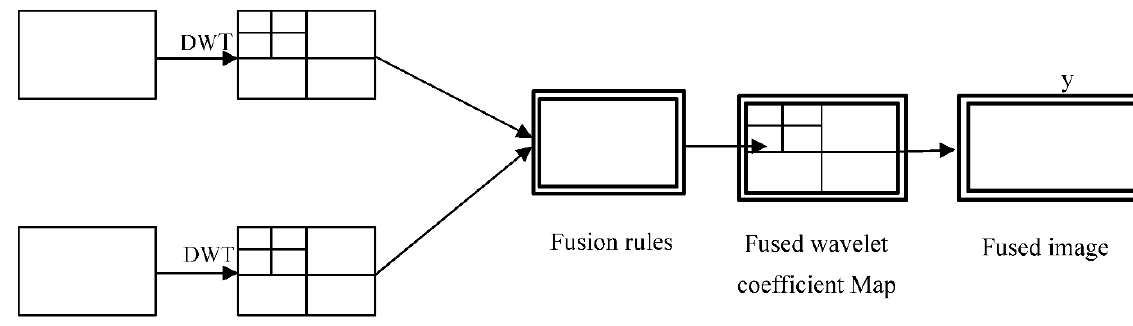
Figure 3. The image fusion scheme based on